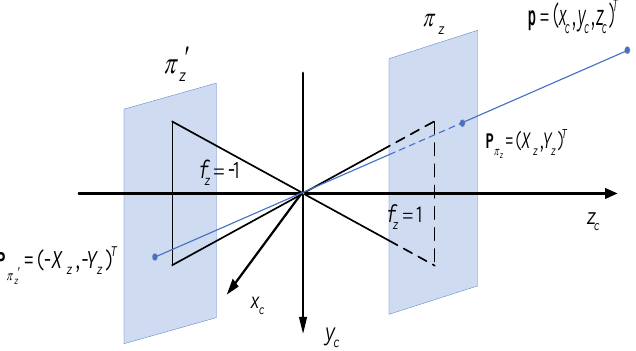
Figure 3. Virtual imaging illustration in π z and π z (cid:48) . The o − x c y c z c coordinate system is fixed in the turntable. Its origin o is the rotation center of the turntable. The plane x c oz c is parallel to the horizontal angle encoder. The x c axis is pointed to the zero position of the horizontal angle encoder. The y c axis is aligned with the vertical axis’s direction downwards and then perpendicular to the horizontal angle encoder. The z c axis is determined by the right-hand rule. A hypothesis is taken as virtual image planes π x , π y , and π z , which are located separately in the planes, i.e., x c = f x , y c = f y , z c = f z . Without loss of generality, f x = f y = f z = 1 is set. A 2D rectangular coordinate system O z − XY is established on the plane π z . The origin O z is the intersection of the z c axis and π z plane. The X and Y axes are aligned separately with the x c and y c axes. The relationship between the virtual image point P π and the 3D point p = ( x c , y c , z c ) T in o − x c y c z c is expressed